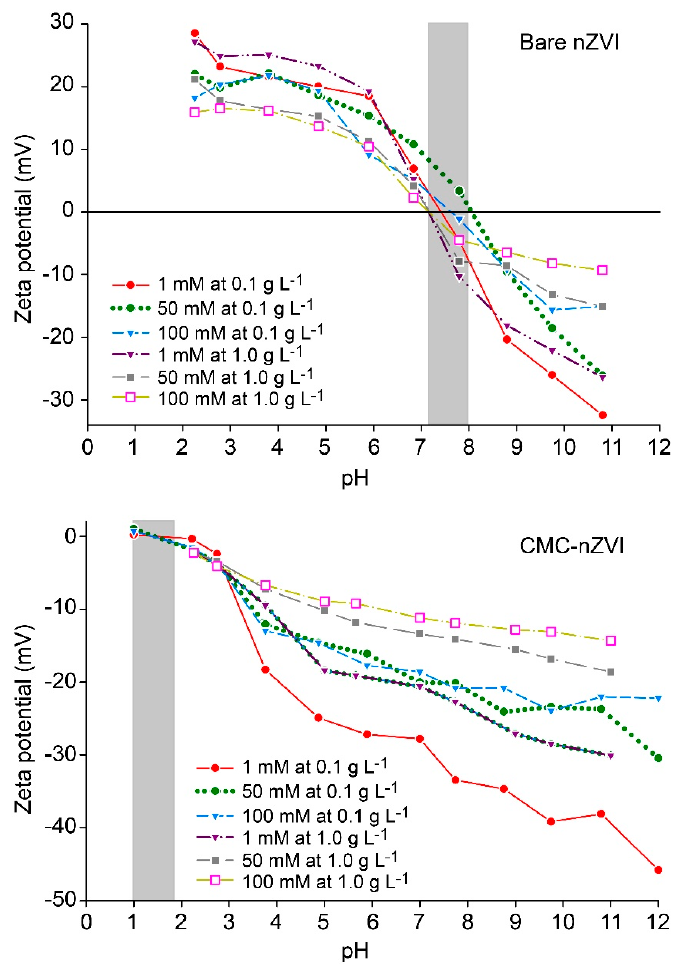
Figure 4. Effect of CMC polymer stabilizer, pH, and IS on the zeta potential of nZVI particles. Table 2. Effect of nZVI particle concentration, CMC polymer stabilizer, IS and pH on zeta potential (mV) of nZVI.